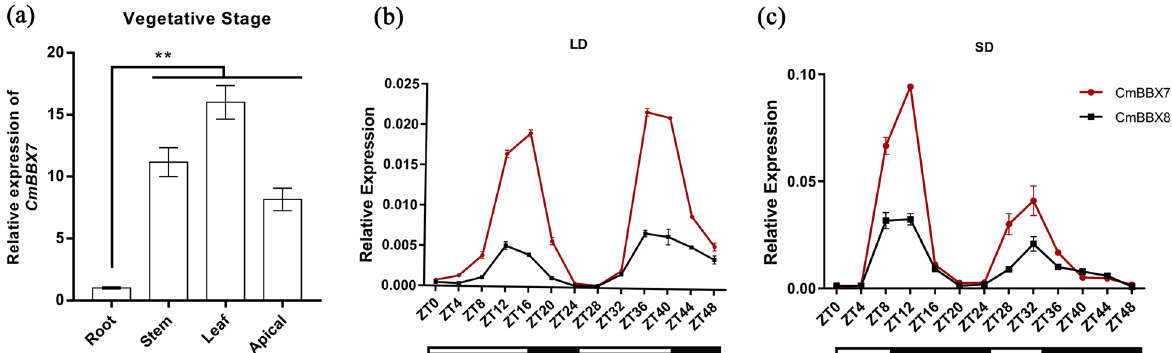
Fig. 2 Transcriptional expression analysis of CmBBX7 in chrysanthemum cv. ‘Yuuka’. a Relative mRNA expression levels of CmBBX7 in various parts of the plant during the vegetative stage. Error bars indicate the standard errors for three biological replicates. Significant differences are indicated with asterisks (** p < 0.01, ANOVA with Tukey’s post-hoc test). b , c The transcriptional response of CmBBX7 , and CmBBX8 to varying photoperiods [long day (LD) and short day (SD)]. The abscissa indicates the sampling time point. Values shown are the means ( n standard errors of the